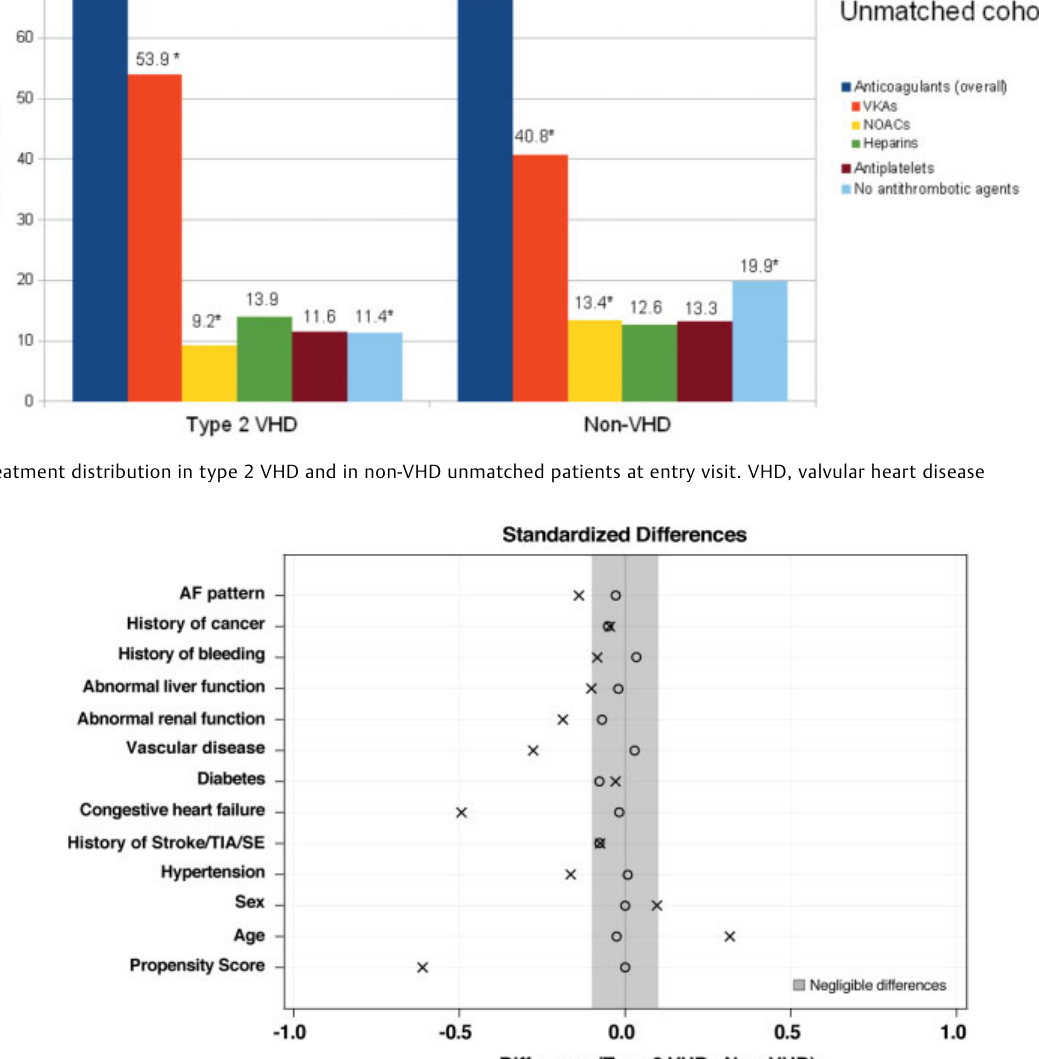
TH Open Vol. 3 No.